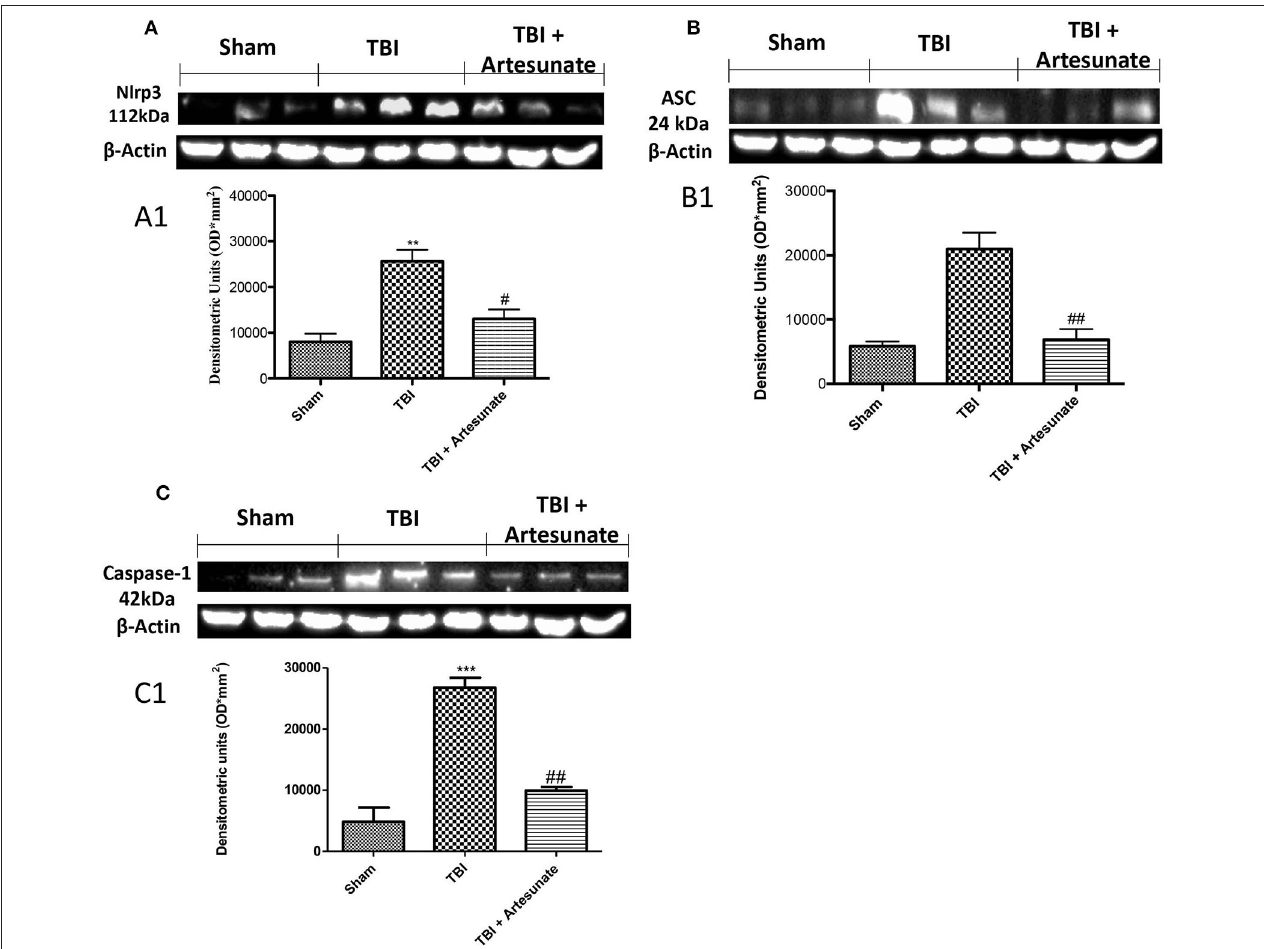
FIGURE 4 | Effect of artesunate on inflammasome components. Western blot analysis show that 24h after TBI injury in the TBI group there is a significantly increase in expressions of NLRP3 (A) , ASC (B) , and caspase-1 (C) . When compared with TBI group, treatment with artesunate significantly reduce the expression of inflammasome components as show in (A) for NLRP3 see densitometric analysis (A1 , B) for ASC see densitometric analysis (B1,C) for Caspase-1 see densitometric analysis (C1) . Data are expressed as Mean ± SEM from N = 10 Mice for each group, ** p < 0.01 vs. respective sham. *** P < 0.001 vs. corresponding sham group; # P < 0.05 vs. corresponding TBI. ## p < 0.01 vs. corresponding TBI. ( F -value for NLRP3 = 18.30. df = 2. r 2 = 0.8591) ( F -value for ASC = 23.14. df = 2. r 2 = 0.8852) ( F -value for Caspase-1 = 47.25. df = 2. r 2 = 0.9403) (see the Supplementary Figures 3–5 for the triplicate of western